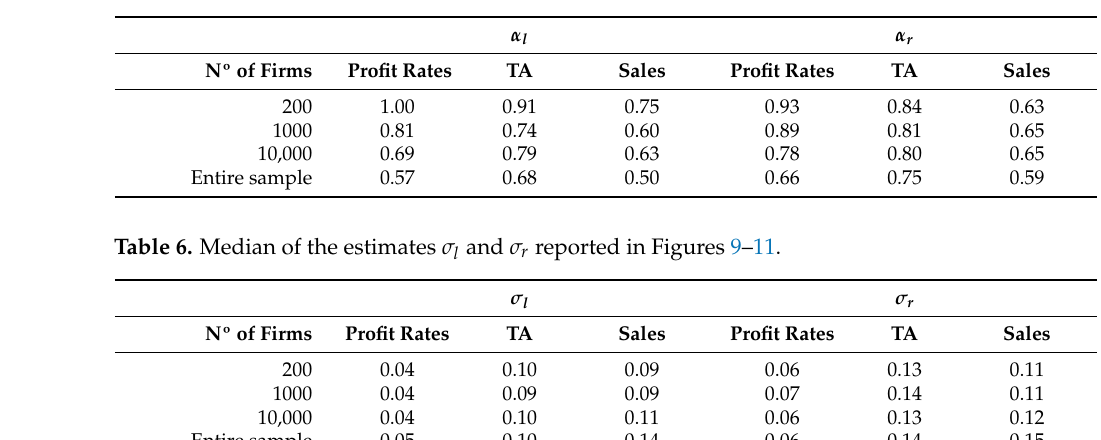
Figure 10. Estimates of the two shape parameters ( α l and α r ) and two scale parameters ( σ l and σ r ) of the AEP distribution for growth rates of total assets conditional on size. Error bars show two standard errors. Gray and black dashed lines refer to the median of the estimates of σ l and σ r , respectively. Table 5. Median of the estimates α l and α r reported in Figures 9–11.